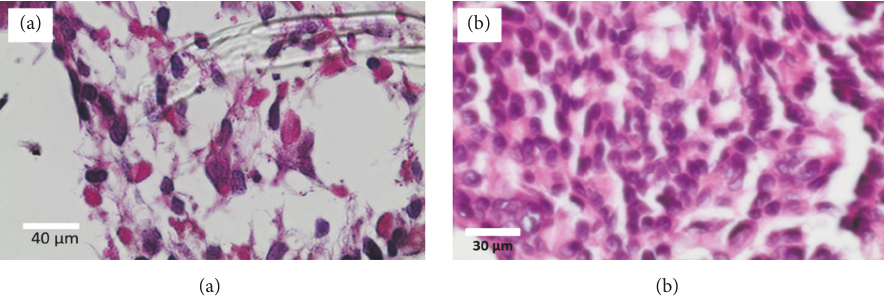
Figure 7: Optical microscopic images of histological stained section of human osteoblast cells grown on (a) pristine PLA fibers and (b) PLA/10wt% HA